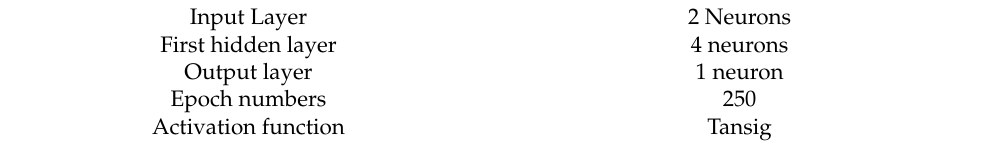
Figure 10. A neural network structure for identifying the flow regimes. The performance of the employed network for the training and testing processes for regime classification are illustrated in Figure 11.